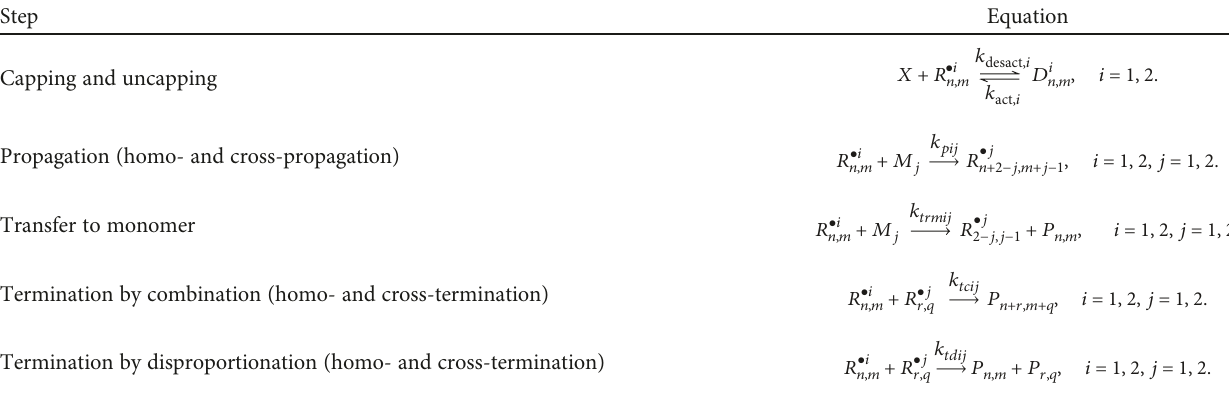
Table 1: Kinetic steps of a nitroxide-mediated copolymerization in terms of the reacting polymer chains.